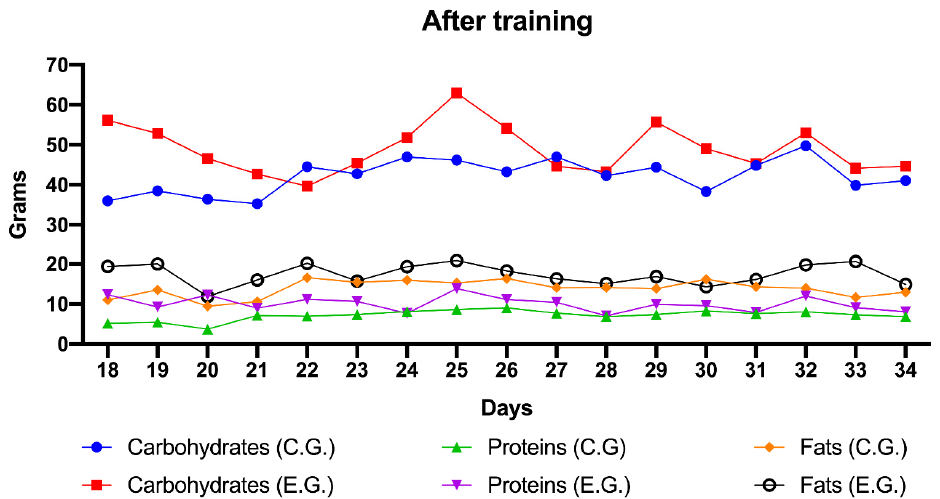
Figure 2. Values expressed in grams of carbohydrates, proteins and fats, of the control and experimental group’s snacks after training the experimental group (daily data from day 18 to day 37). Note. C. G.: Control Group; E.G.: Experimental Group.